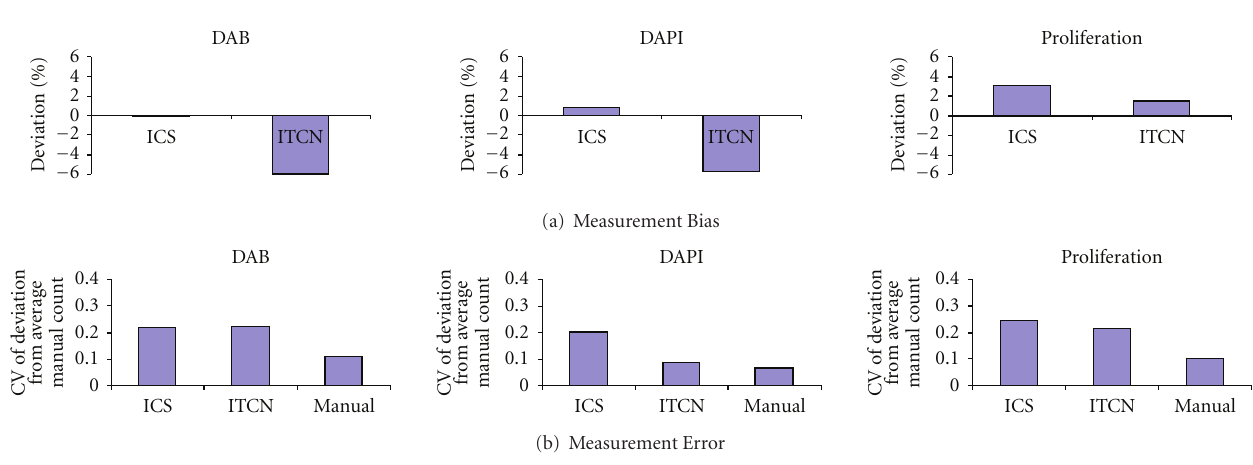
counts of DAB-stained cells (brightfield microscopy)